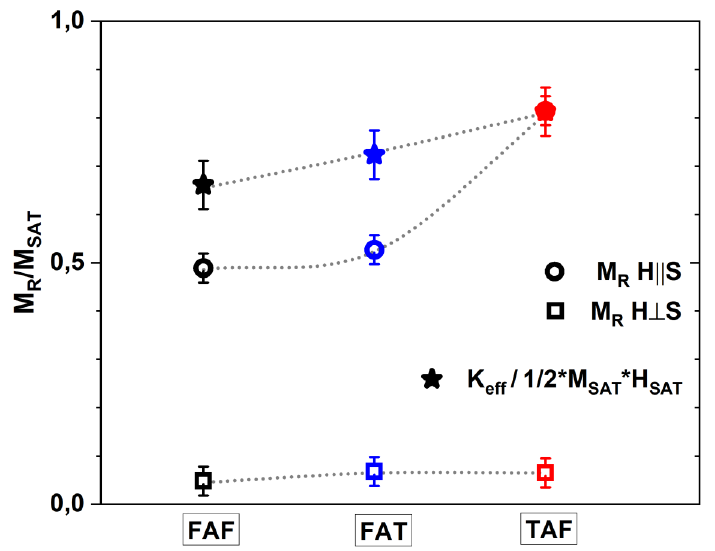
Figure 5. Normalized remanence magnetization ( M R / M SAT ) values for H (cid:107) S and H ⊥ S directions and normalized anisotropy constant calculated for FAF, FAT, and TAF junctions at room temperature. The hysteresis curves were also used to evaluate the switching field H SF and its dis- tribution. The switching field, defined as the field at which the inflexion on the M ( H ) curve occurs corresponding to the situation when a maximal number of magnetic moments changes orientation for opposite, has been calculated as a maximum of M ( H )